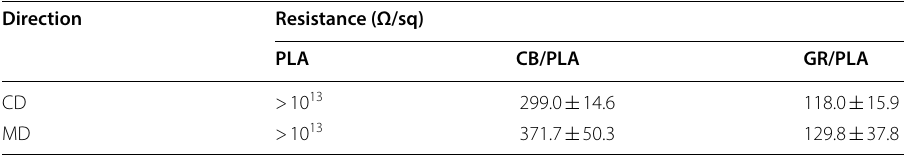
Table 5 Surface resistance of 3D printed honeycomb samples